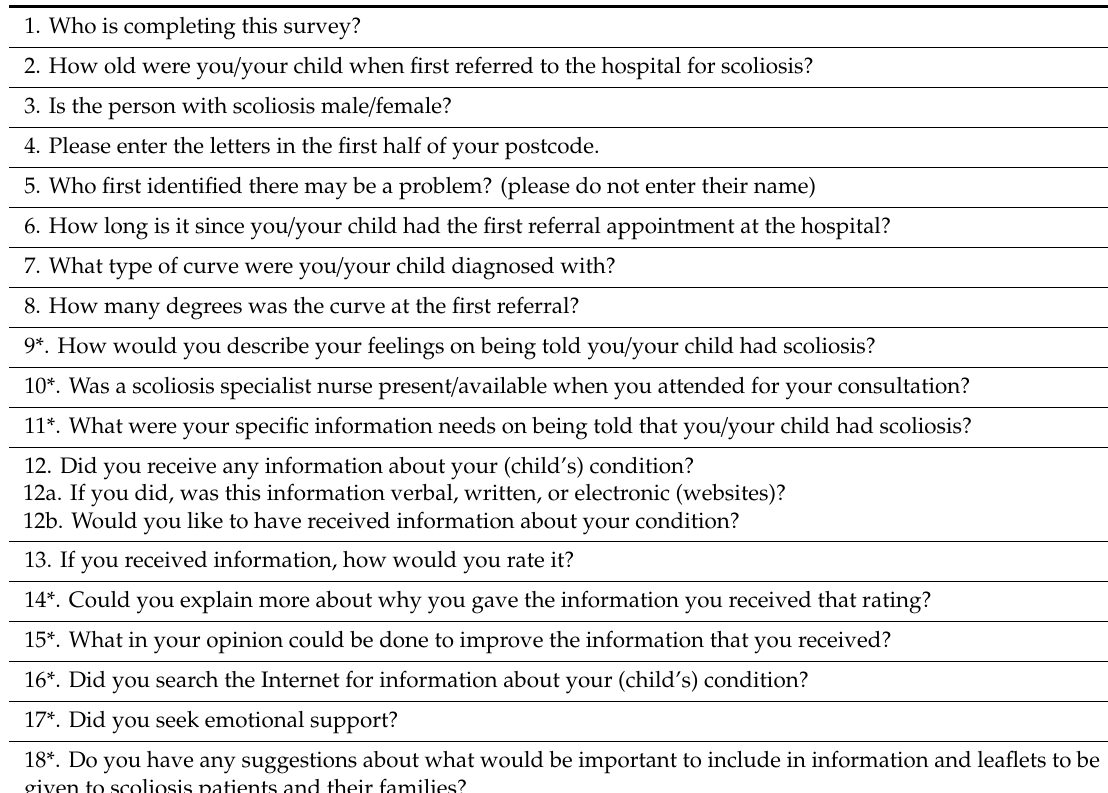
Table 1. Patient Survey